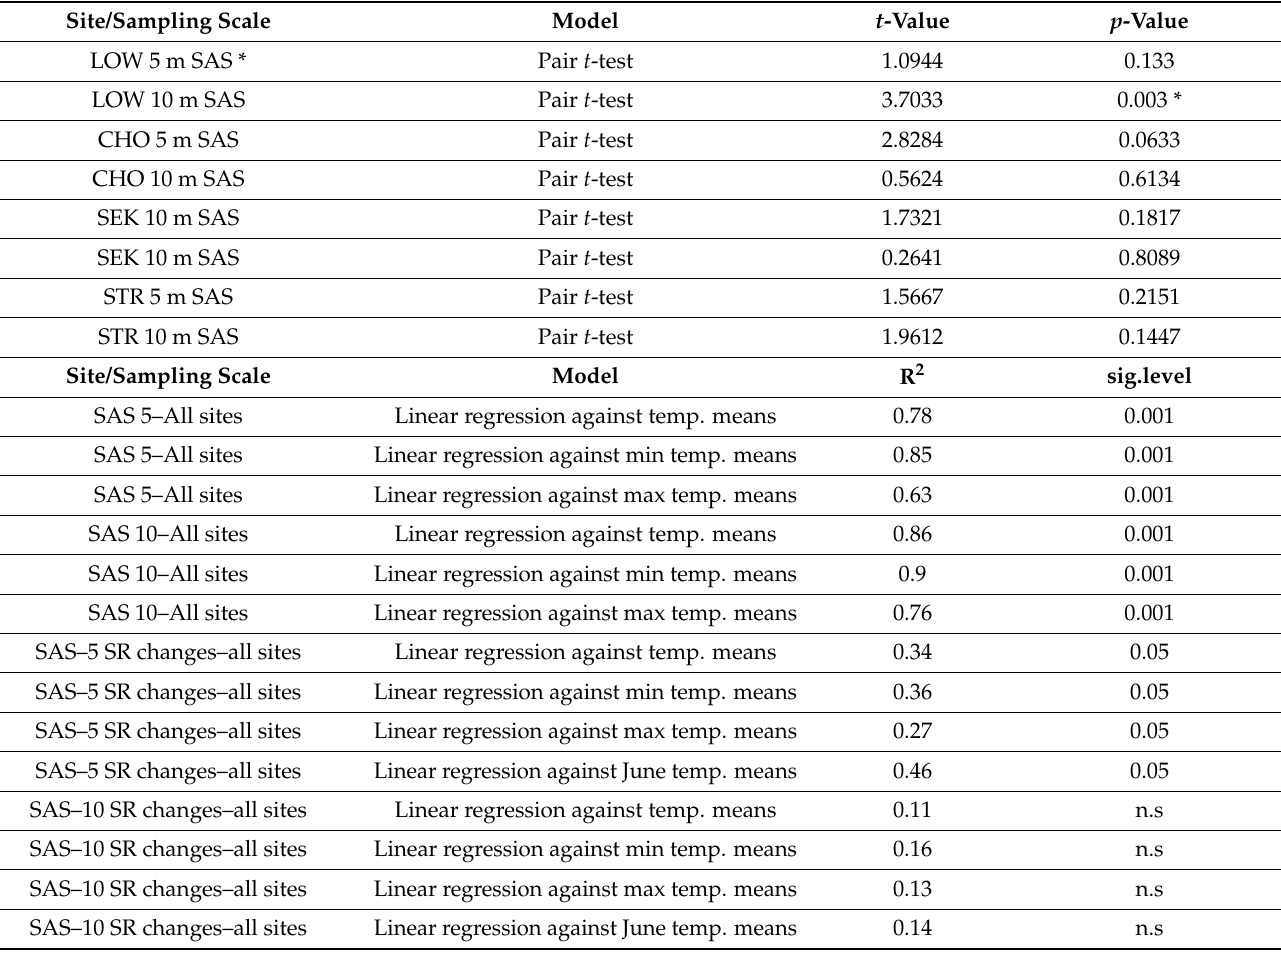
Table 4. Statistical tests on species richness data comparing 2001 and 2008